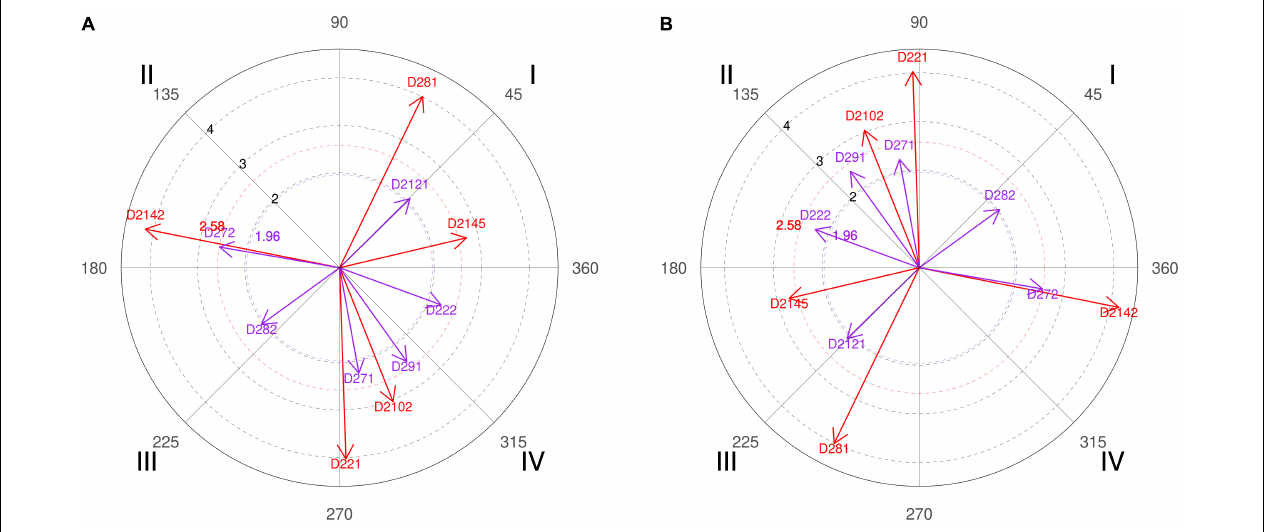
FIGURE 2 | (A,B) Relationship of conditioned behaviors that present a significant relationship with the focal behaviors “favorable evaluation” and “unfavorable evaluation” analyzing question 5 of the in-depth interviews. In “favorable evaluation,” a total of 11 significant vectors were detected and in “unfavorable evaluation,” a total of 11 significant vectors were